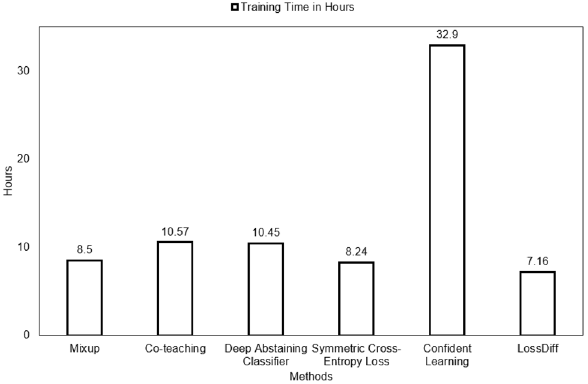
Figure 12. Training time comparison for different noise reduction